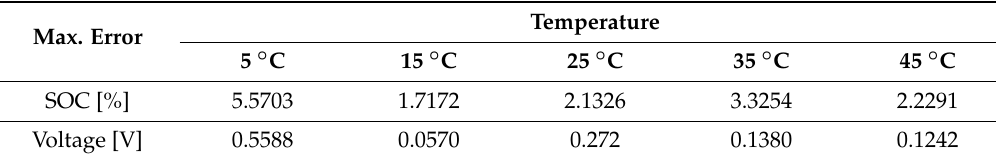
Table 5. SOC and voltage maximum estimnation